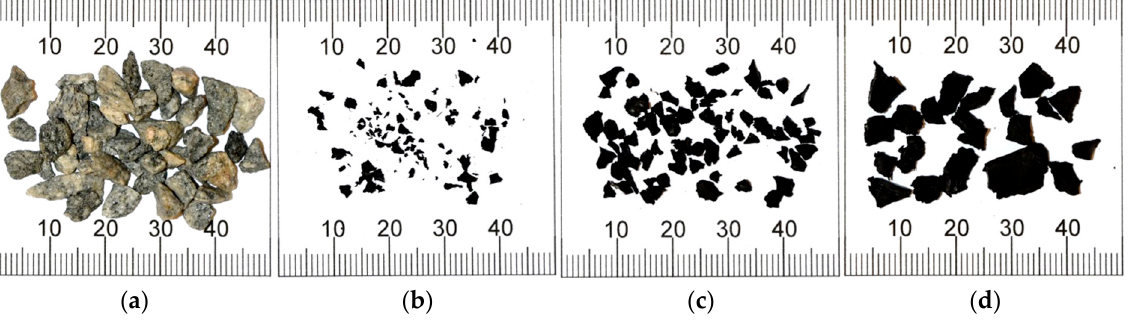
The recycling process used a shredding technique at ambient temperature. Different fractions of crumb rubber were used in this project: 0.5/2, 1/4, and 4/7 mm. Coarse crushed gneiss aggregate of the 2/5 mm fraction and crumb rubber of different sizes are shown in Figure 2.